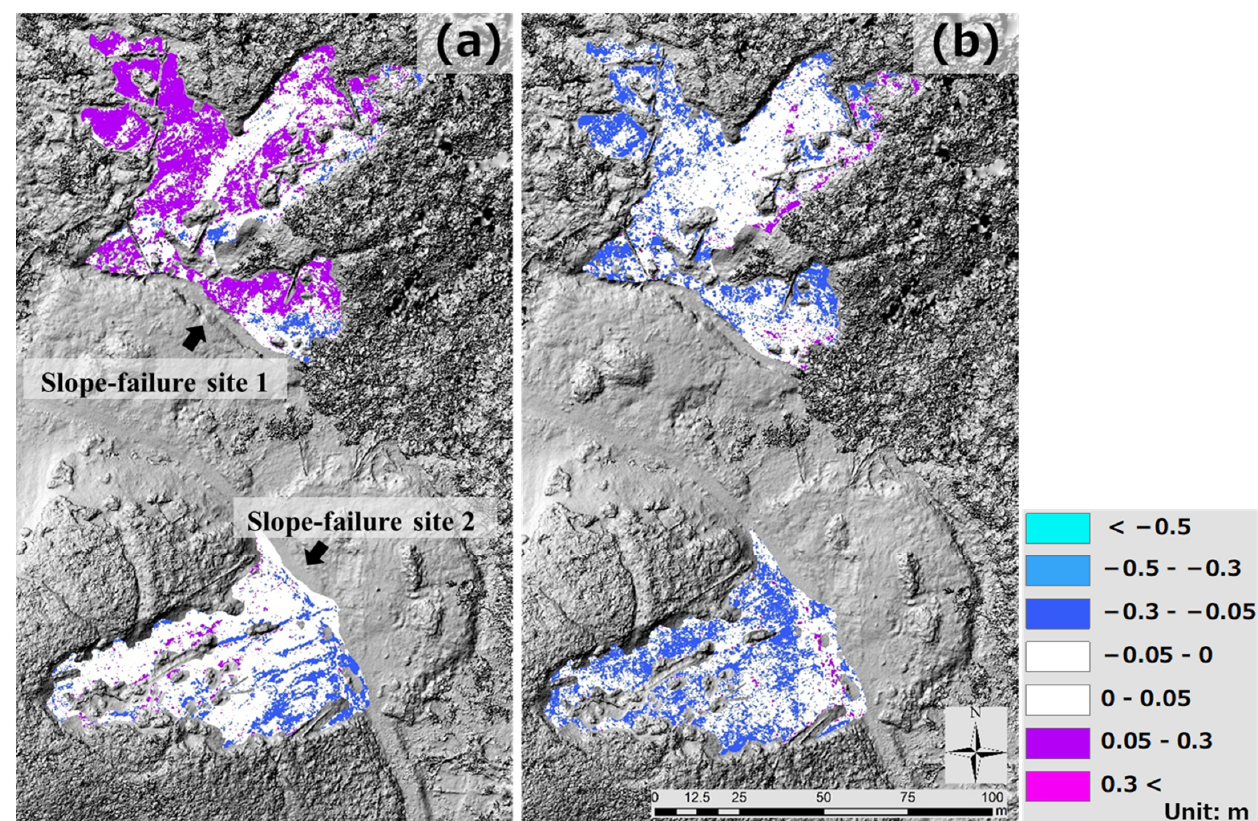
Figure 5. ( a ) Map of altitude change indicating the amount of frost heaving (4/3 a.m.–4/2 p.m.). ( b ) Map of altitude change indicating the amount of frost thawing (4/3 p.m.–4/3 a.m.).